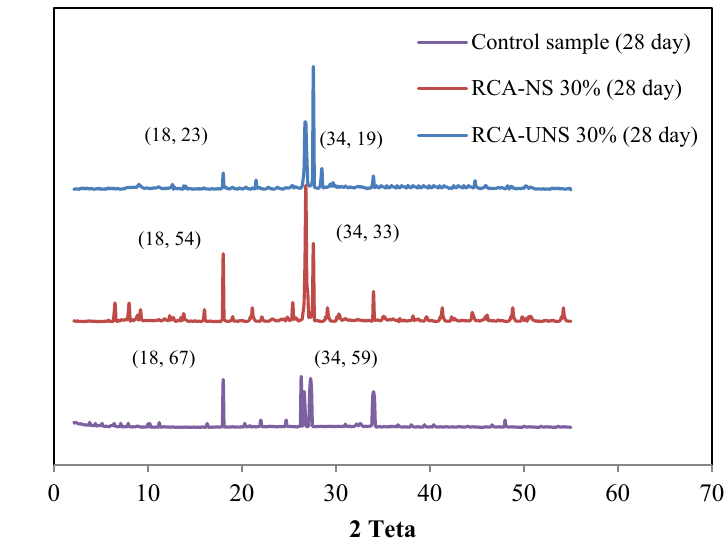
Figure 11. X-ray diffraction (XRD) of Control, RCA-NS 30%, and RCA-UNS 30% samples at 28 days.